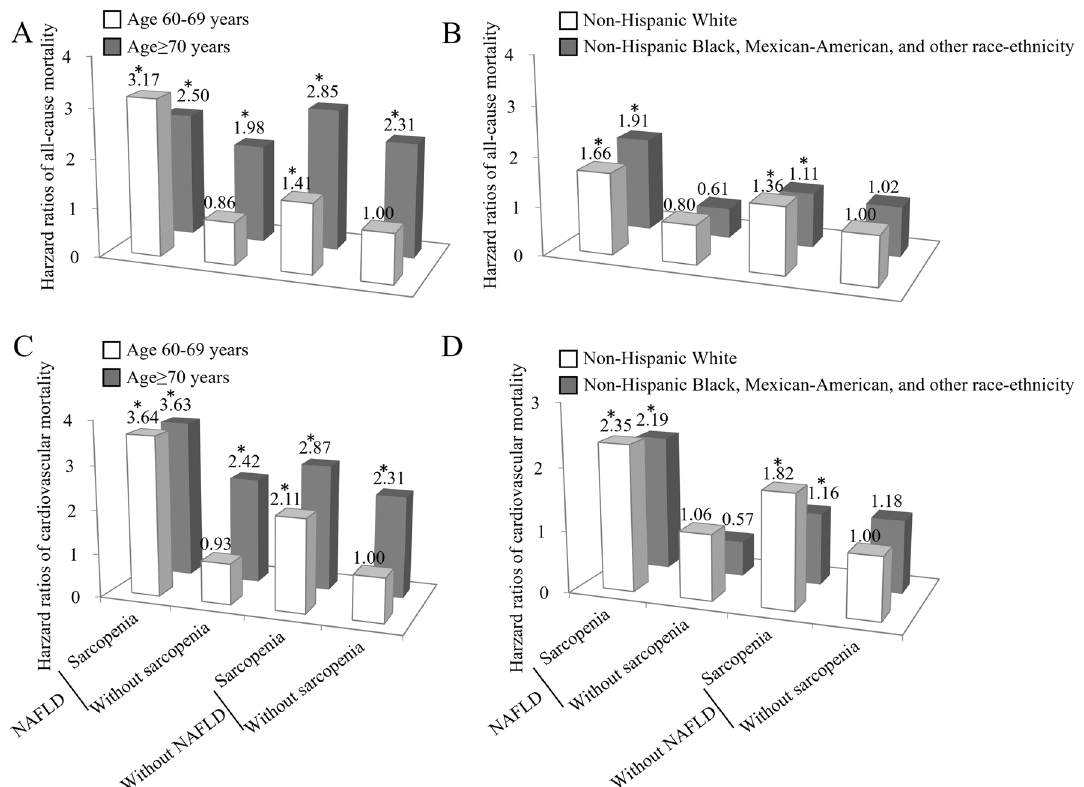
Figure 2. Joint effects of nonalcoholic fatty liver disease (NAFLD) and sarcopenia on all-cause mortality (upper panel) and cardiovascular mortality (lower panel) after stratification for age, and race-ethnicity. *All-cause and cardiovascular mortality risks were significantly higher in sarcopenic subjects with NAFLD regardless of the age group and race-ethnicity. For the age subgroup, hazard ratios (95% confidence intervals) were adjusted for gender, race-ethnicity, education level, smoking and drinking status, body mass index, total cholesterol, triglyceride, HDL-cholesterol, and comorbid conditions such as stoke, coronary heart disease, and chronic obstructive pulmonary disease. For the race-ethnicity subgroup, hazard ratios (95% confidence intervals) were adjusted for gender, age, education level, smoking and drinking status, body mass index, total cholesterol, triglyceride, HDL-cholesterol, and comorbid conditions such as stoke, coronary heart disease, and chronic obstructive pulmonary disease. Statistics and P values were showed in Supplementary Table